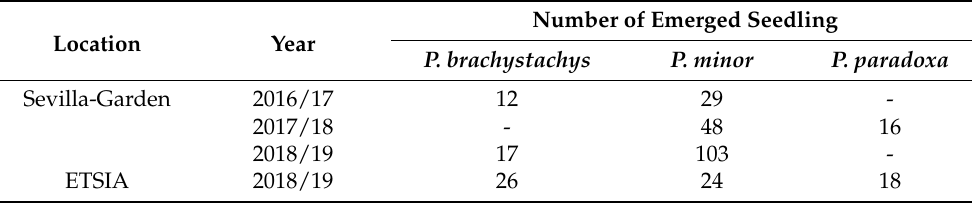
Table 2. Total emergence for the independent experiments. Location